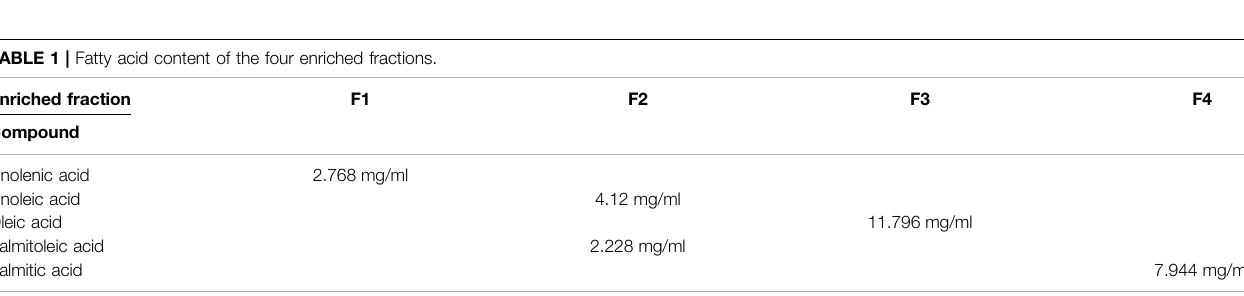
TABLE 1 | Fatty acid content of the four enriched